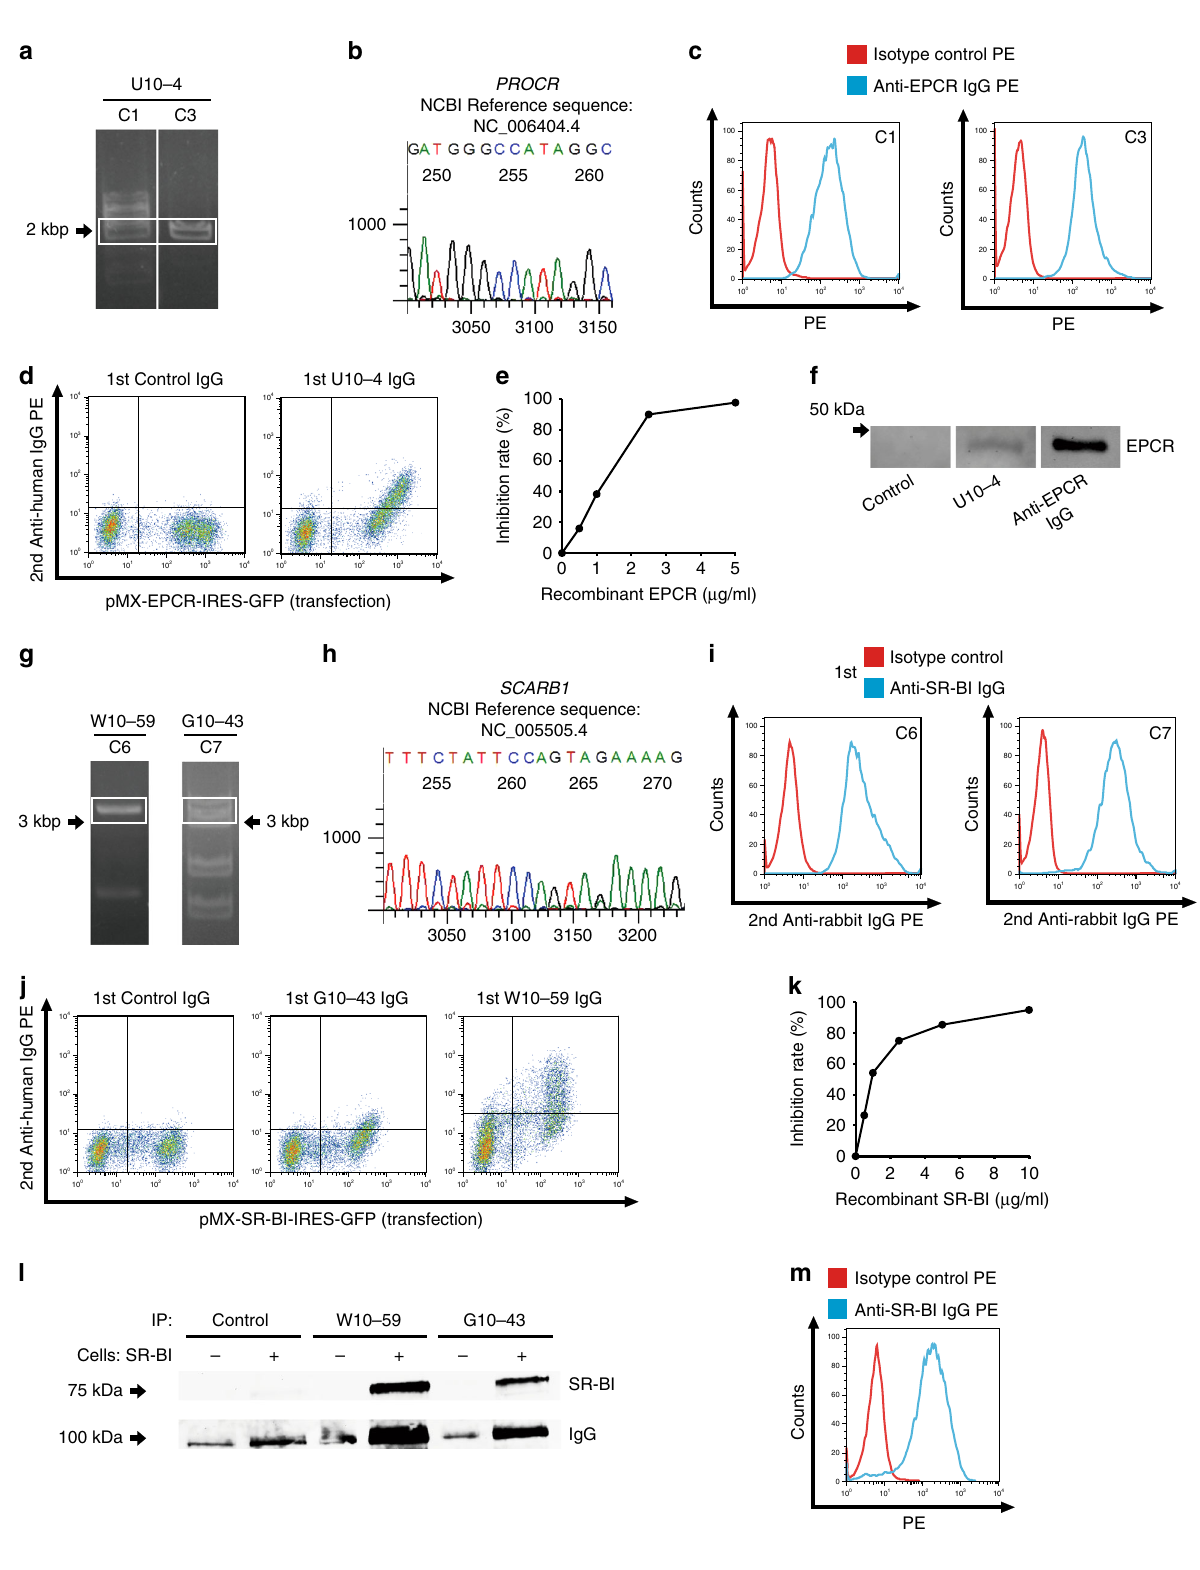
Discussion Identi fi cation of major autoantigens in TAK would signi fi cantly affect clinical practice and vasculitis research. In this study, we analyzed autoantigens in TAK by using SARF. EPCR and SR-BI (integrated membrane protein receptors) were found to be